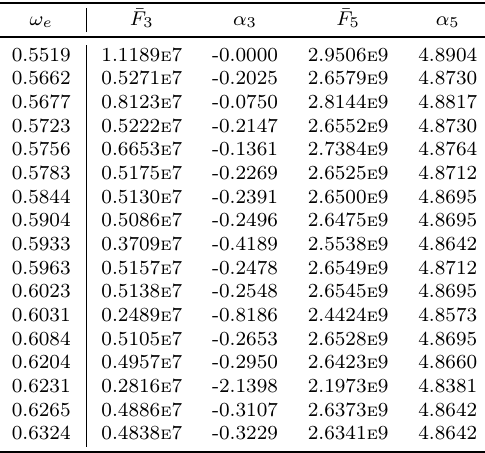
Table 16: External wave